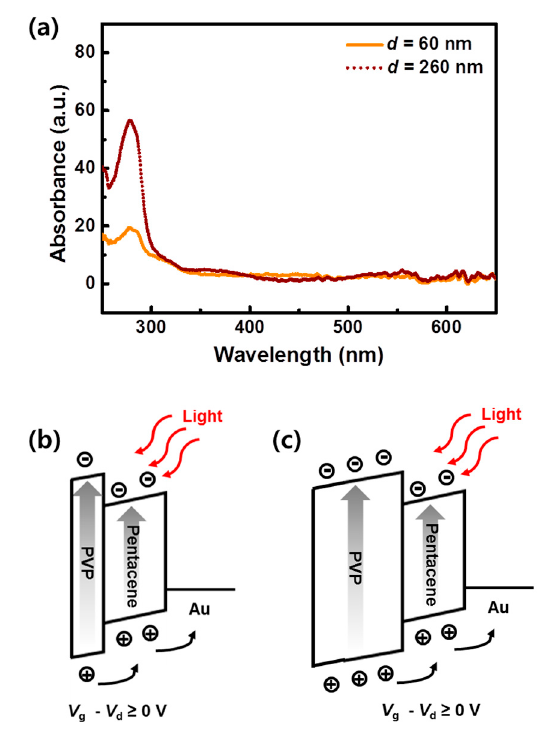
Figure 4. ( a ) UV-vis absorbance of PVP layers with thickness d = 60 and d = 260 nm. Schematics representing the operating mechanism of the OPTs with ( b ) d = 60 and ( c ) 260 nm.